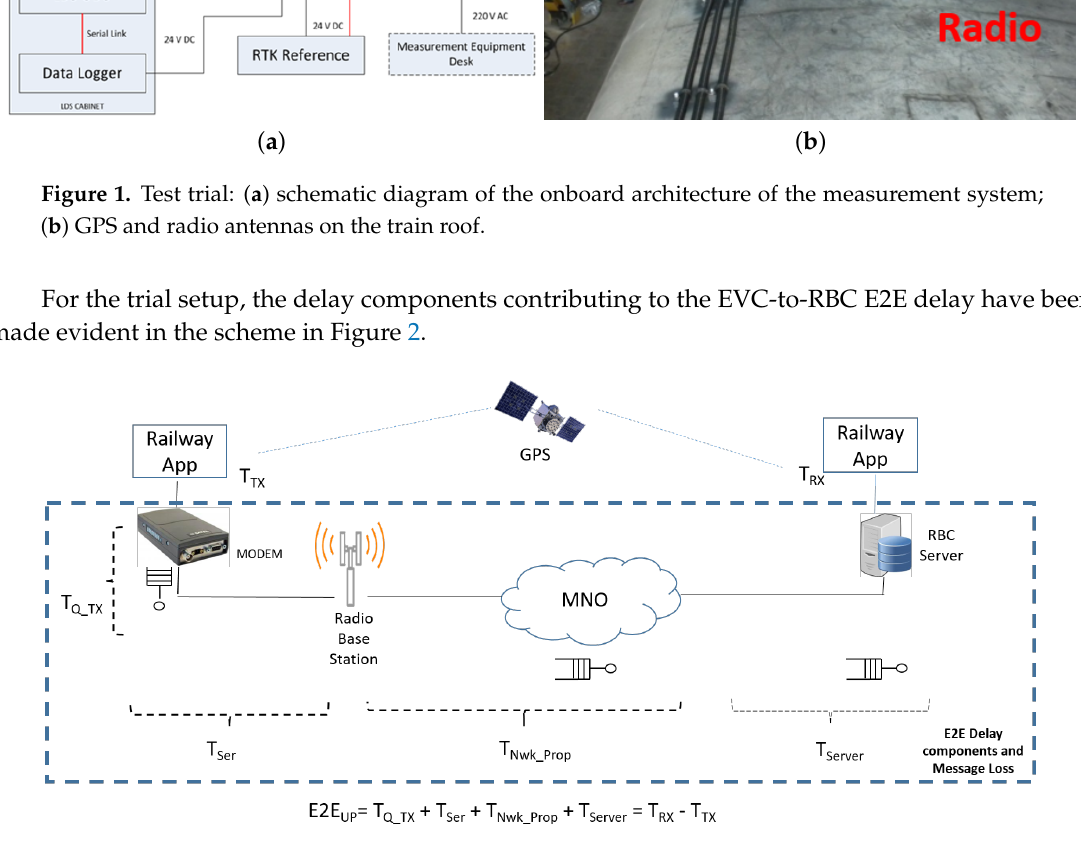
Figure 2. Delay components contributing to the overall end-to-end (E2E) delay between the transmitted and received messages—EVC to RBC